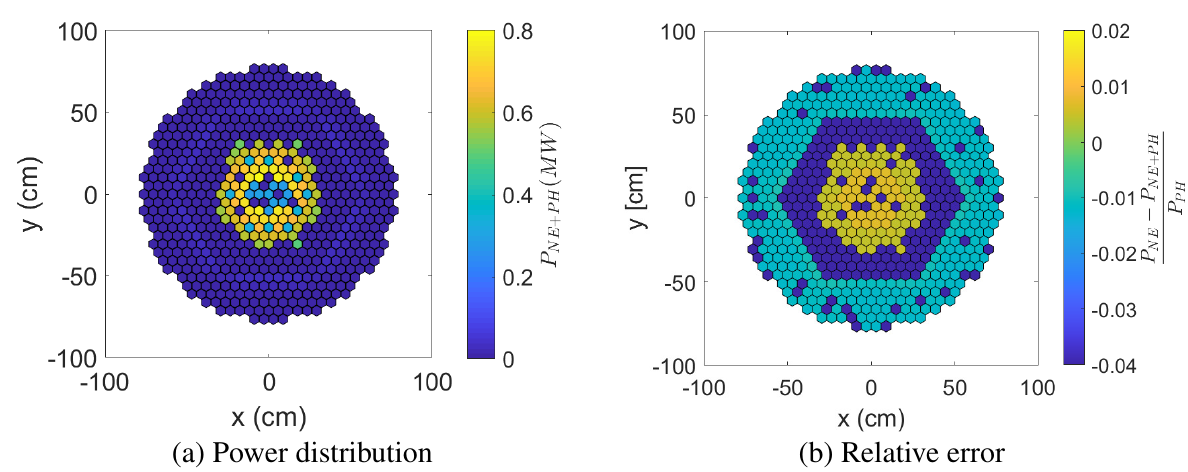
Figure 2: Radial map of the power per FA computed with (NE+PH) and without (NE) the photon transport and energy deposition